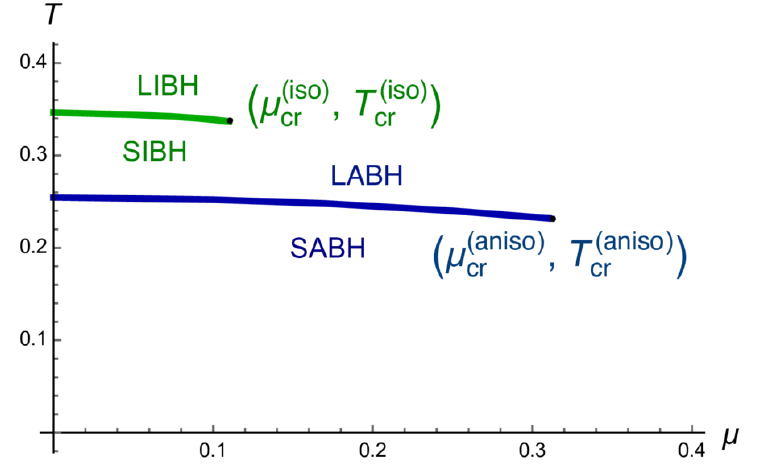
Figure 29 . The phase diagrams in the ( T; (cid:22) )-plane for the isotropic background (green line) and for anisotropic (cid:23) = 4 : 5 background (blue line). LIBH and SIBH (LABH and SABH) indicate the regions of small and large isotropic (anisotropic) black holes.